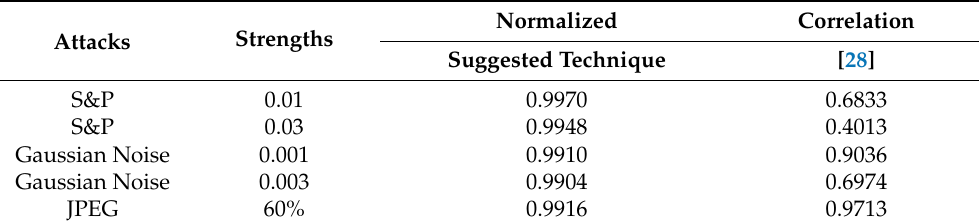
Table 6. Normalized Correlation Against Image Processing Attacks.